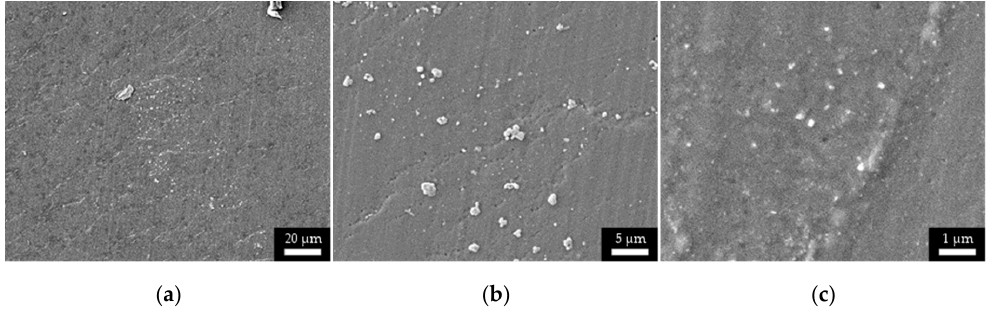
Figure 6. SEM micrographs at different magnification (500x ( a ) –3000x ( b ) –12000x ( c )) of the sintered ink surface embedded in the injection molded part. Micrographs were taken with an E beam power of 5 kV.